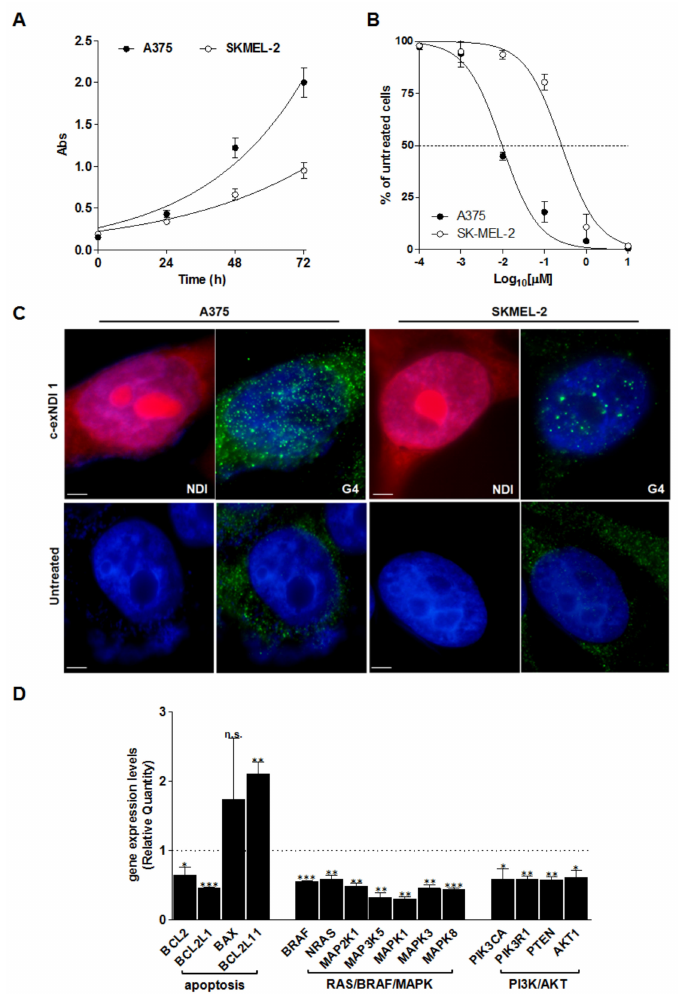
Figure 1. ( A ) Time-dependent assessment of cell growth in untreated A375 and SKMEL-2 cells. Data are reported as the recorded absorbance (Abs) as a function of time and represent mean values ± s.d. from at least three independent experiments. The curves represent the exponential growth equation obtained by nonlinear fit of data points using GraphPad Prism 5.01 (GraphPad Software Inc., San Diego, California, United States). ( B ) Dose-response curves of melanoma cells exposed to increasing concentrations (0.1–10,000 nM) of 1 . Data are reported as the percentage of viable cells with respect to untreated cells as a function of the Log 10 of compound concentrations (for details see Supporting Information Table S2) and represent mean values ± s.d. from at least three independent experiments. ( C ) Representative photomicrographs showing the uptake of the G4 ligand (red) and the occurrence of G4 structures (green) in A375 and SKMEL-2 cells exposed to c-exNDI 1 (IC 50 ) for 48 h and analyzed by fluorescence microscopy. The panels on the bottom show untreated cells. Nuclei were counterstained with DAPI. Magnification: × 100; bars: 10 µ m. ( D ) Analysis of gene expression levels in A375 cells upon 48 h of exposure to 1 (IC 50 ). Data are reported as Relative Quantity (mean RQ values ± s.d.) in treated vs. untreated cells, according to the 2 − ∆∆ Ct method. Dotted line: calibrator sample. * p < 0.05; ** p < 0.01; *** p < 0.001 (Student’s t